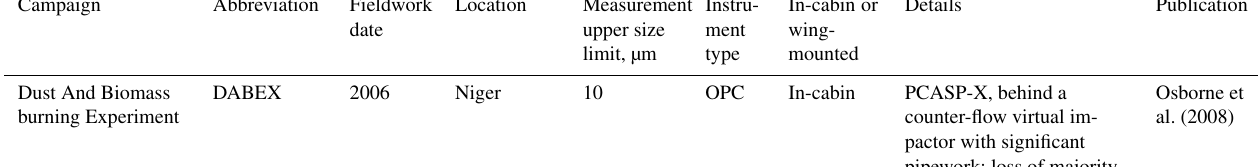
Table 1. Airborne campaigns measuring size distributions of Saharan mineral dust since 2006, showing maximum particle size measured and size restrictions by inlets where instruments were located inside the aircraft cabin. OPC size ranges are nominal diameters. See text for abbreviations. APS: aerodynamic particle sampler; CAS-DPOL: cloud and aerosol spectrometer with depolarization detection; FSSP: forward scattering spectrometer probe; SID: small ice